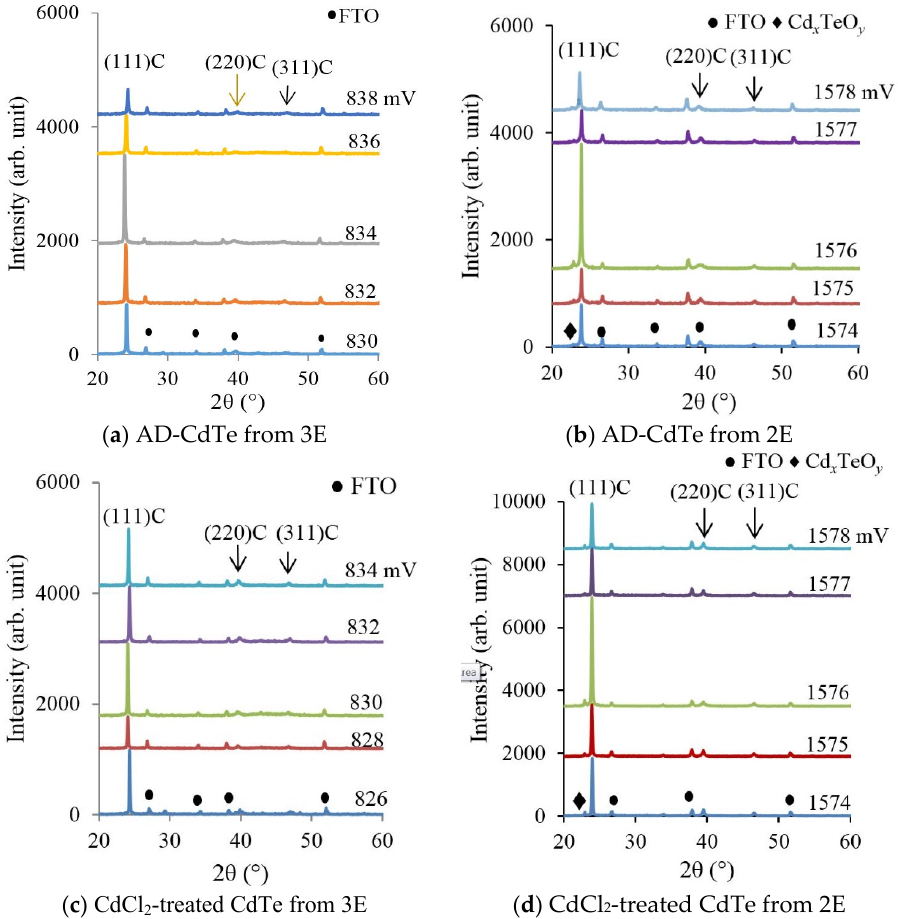
Figure 2. XRD patterns for as ‐ deposited (AD) CdTe films deposited at different growth voltages using the ( a ) 3E and ( b ) 2E systems. ( c , d ) XRD patterns for CdCl 2 ‐ treated layers. All heat treatments were carried out at 400 °C for 15 min in air in the presence of CdCl 2 .